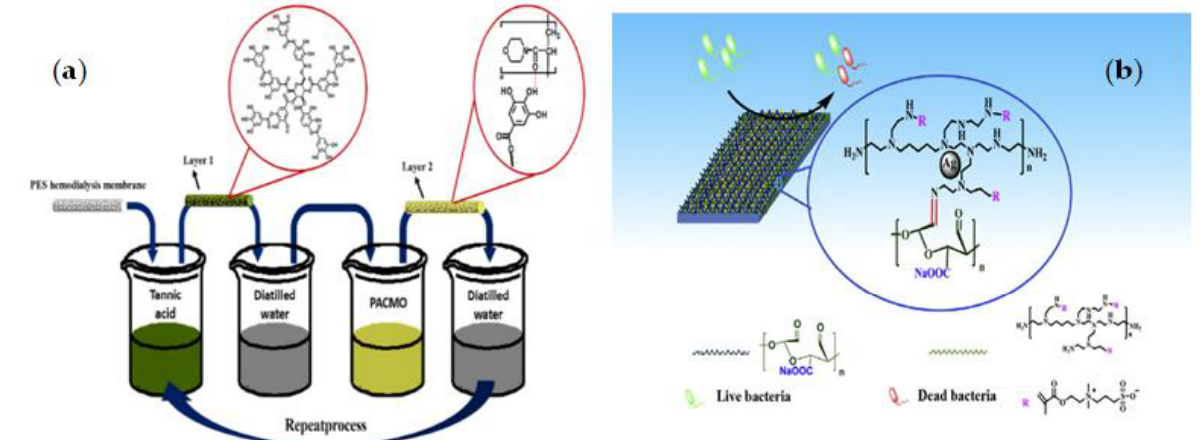
Figure 5. ( a ) The synthetic procedure ofPES/TA-PACMO via the LBL method [111]. ( b ) Preparation of PES/PEI-SBMA-Ag and PES/PEI-SBMA/OSA-n-Ag via Schiff-based LBL [112].